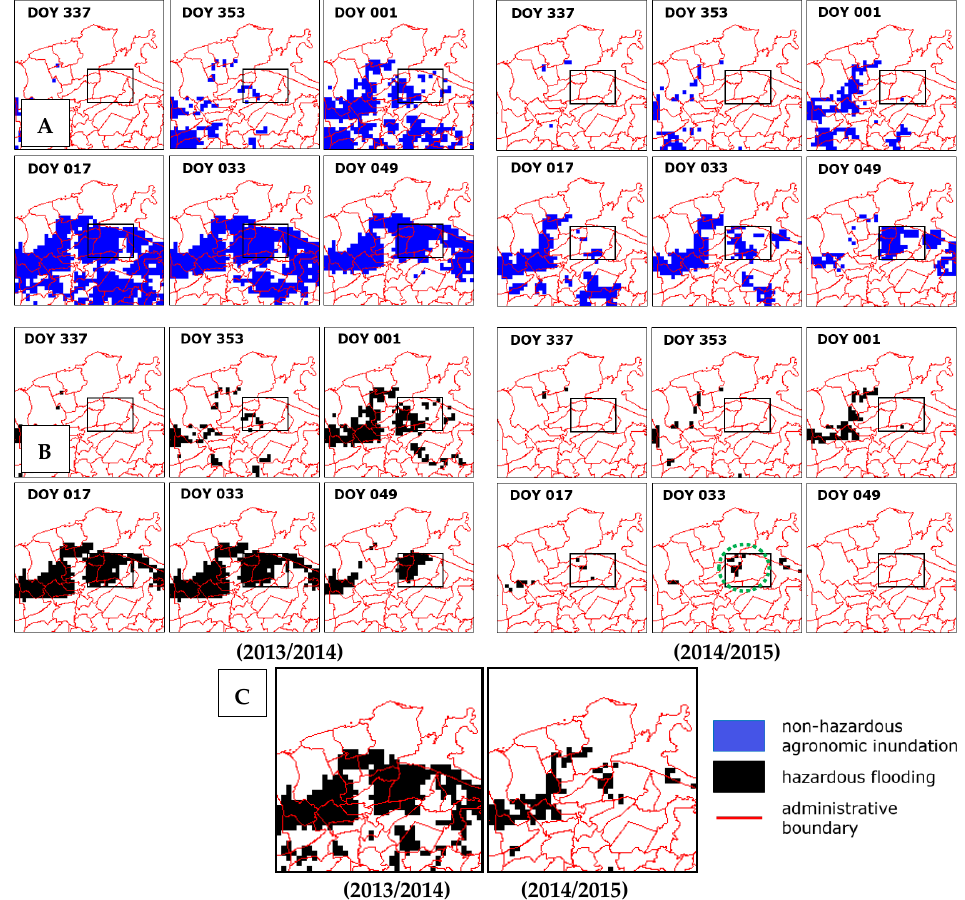
Figure 6. Rice fields with ( A ) surface water detected using EVI ≤ 0.1 (blue) and ( B ) with flooding detected using EVI40 (black). Black rectangle represents rice fields affected by a dike failure on January 18, 2014. Dotted green circle is misclassified flooded rice fields. ( C ) Total area rice fields with flooding detected using EVI40 from DOY 337 to 129 in 2013/2014 and 2014/2015. Figure 6 corresponds to Figure 1B.